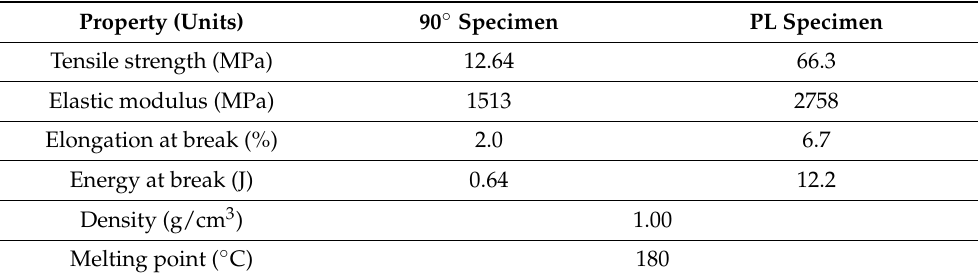
Figure 3. Electron microscope scan of the fracture surface of a broken wire ( a ) and micro-CT scan of the same wire ( b ) where carbon fibers are visible (white straight lines). Table 1. Summary of the datasheet properties of NylForce Carbon, as declared by the manufacturer, FiberForce.